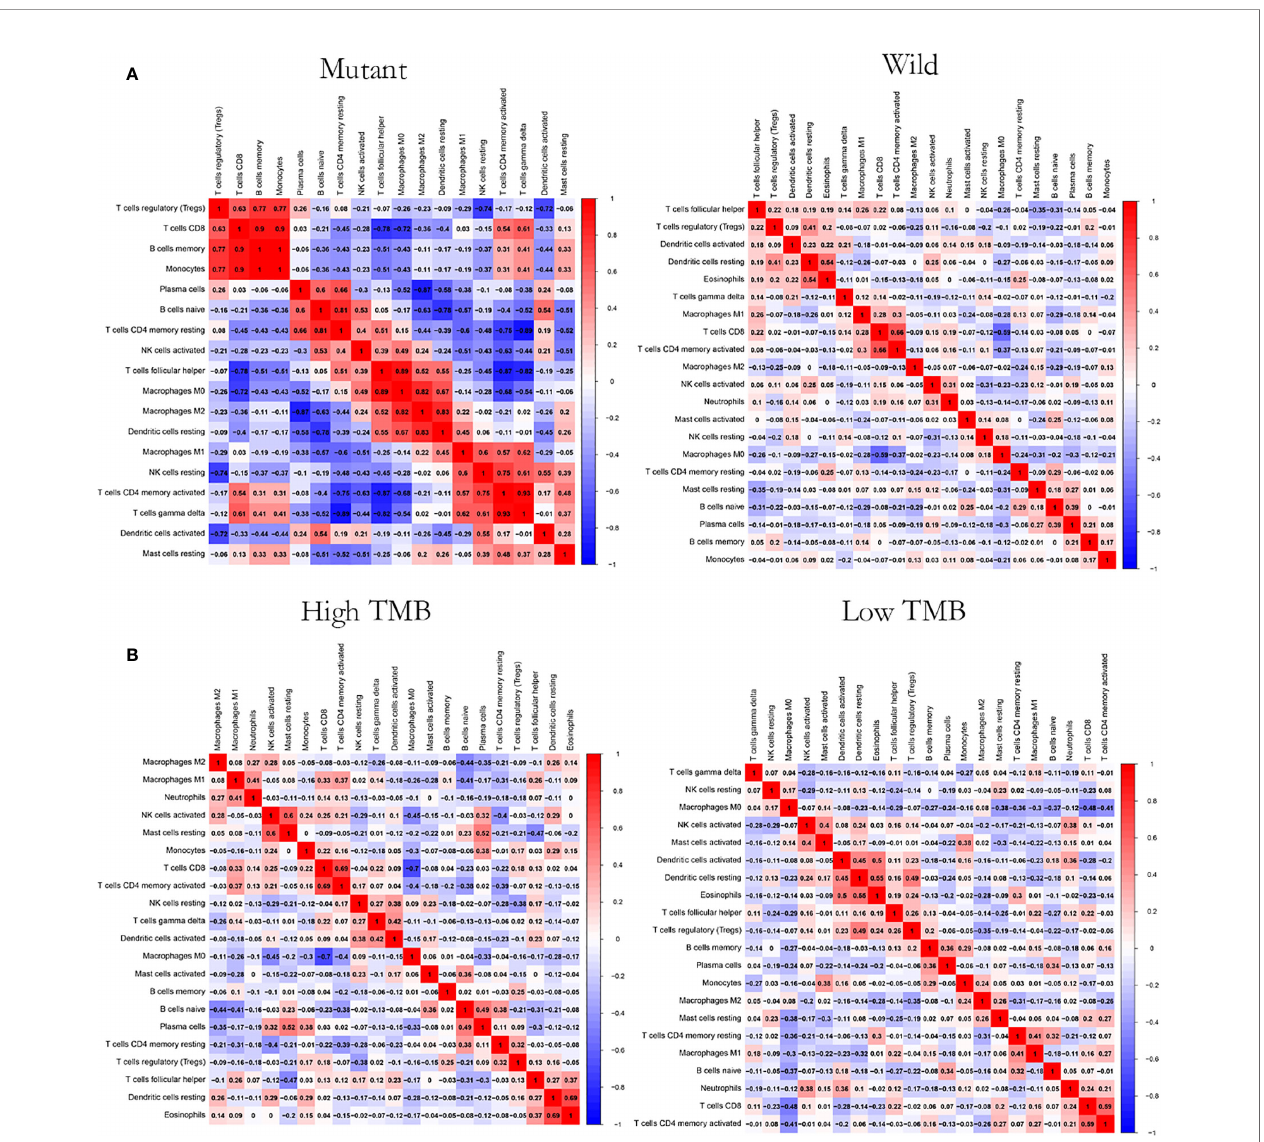
FIGURE 4 | Correlation analysis of immune cell abundance. (A) Between the FAT3 mutant groups and the wild groups (B) Between high and low TMB groups. Red represents positive correlation and blue represents negative correlation. The greater the absolute value of the correlation coef fi cient, the greater the